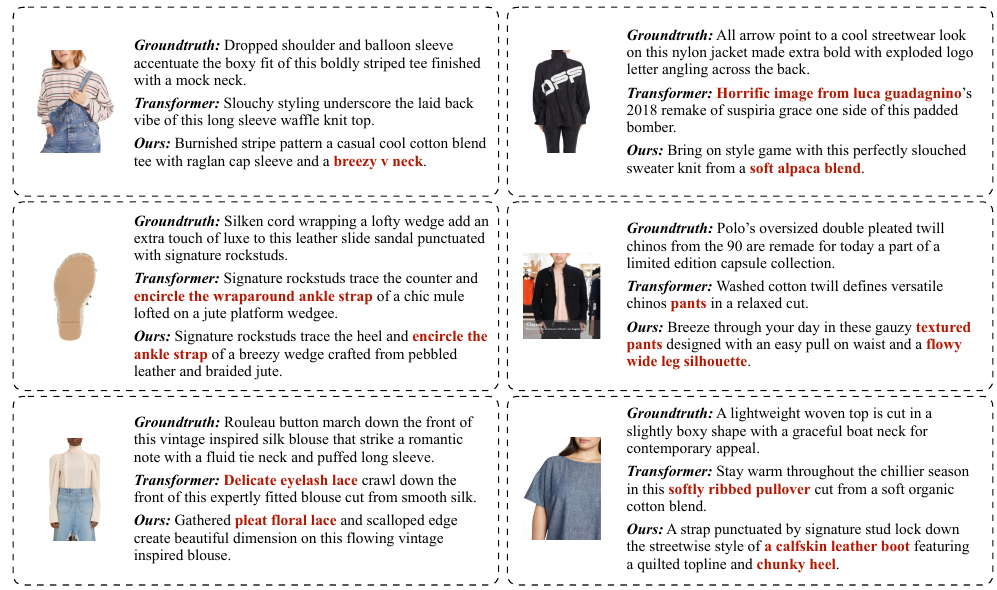
Figure 4. Failure cases of the presented solution, both in the baseline and retrieval